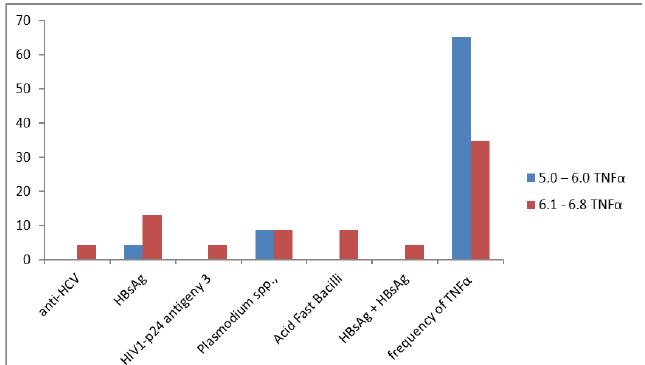
Fig. 1. Frequency of anti-HCV, HBsAg, HIV1-p24 antigen, Acid Fast Bacilli and Plasmodium spp., in herbal home